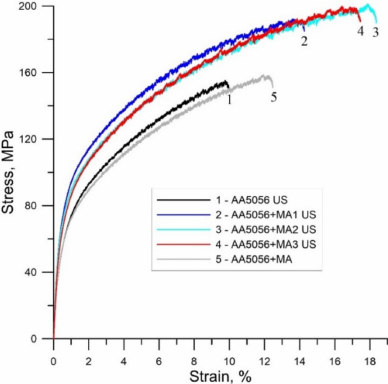
Figure 8. Diagrams of uniaxial tension of AA5056-based cast alloys.